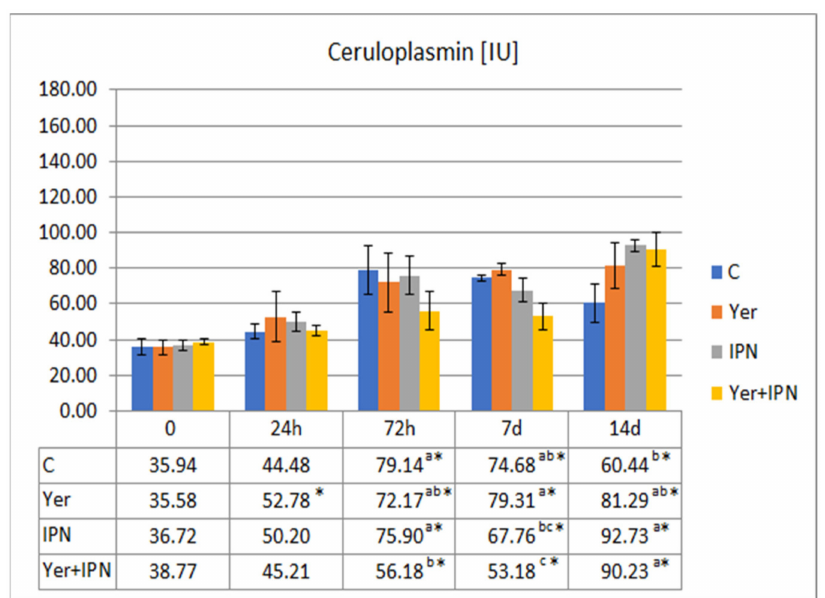
Figure 14. Mean values and standard deviation of ceruloplasmin activity over the course of the second experimental infection. *—statistically significant differences compared to the day 0 values within a given group ( p ≤ 0.05); a, b, c —statistically significant differences between the groups on a given sampling day ( p ≤ 0.05).